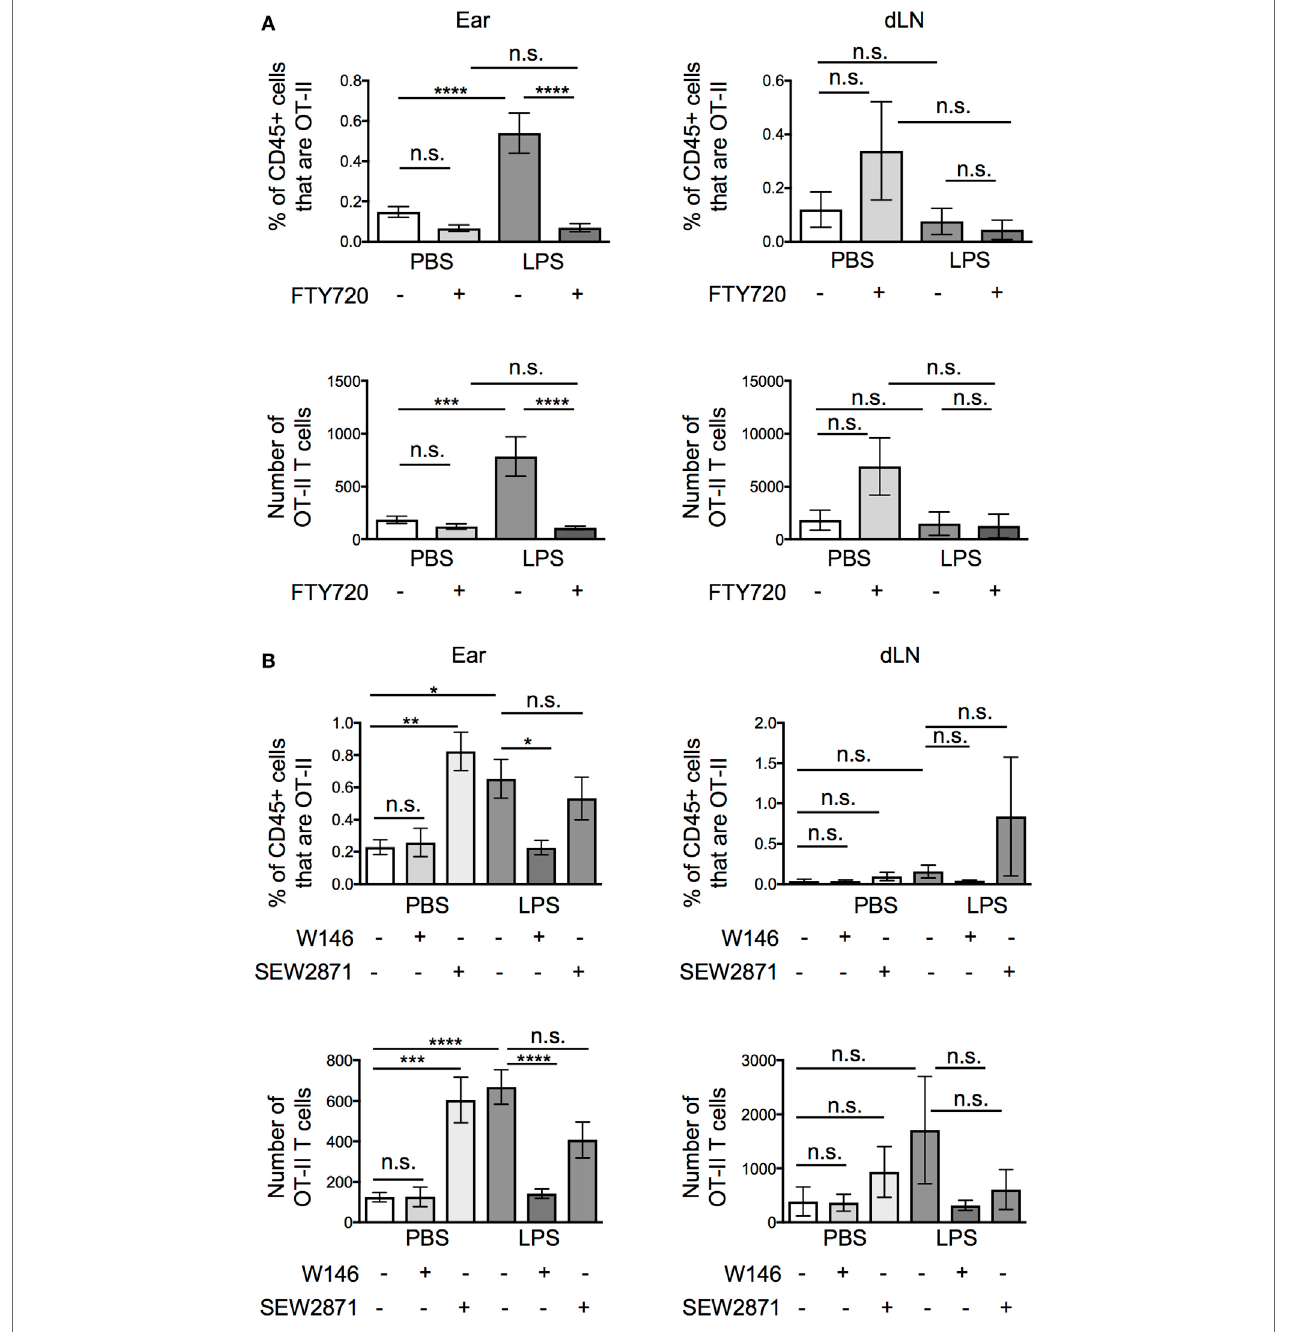
FigUre 5 | Signals through S1PR1 cause increased persistence of activated CD4 T cells at lipopolysaccharide (LPS)-inflamed sites. Activated OT-II T cells were treated with vehicle or FTY720 (a) , or S1P1 receptor specific antagonist (W146) or agonist (SEW2871) (B) before transfer into the ear pinnae of mice injected with PBS or LPS 24 h earlier. After a further 24 h, the percentages and numbers of transferred OT-II T cells in the homogenized ear or draining lymph node were examined by flow cytometry. Data are combined from two to three independent experiments with ≥ 3 animals per group. In this figure, p < 0.05 is indicated by *; p < 0.01 is indicated by **; p < 0.001 is indicated by ***; and p < 0.0001 by ****; n.s.,